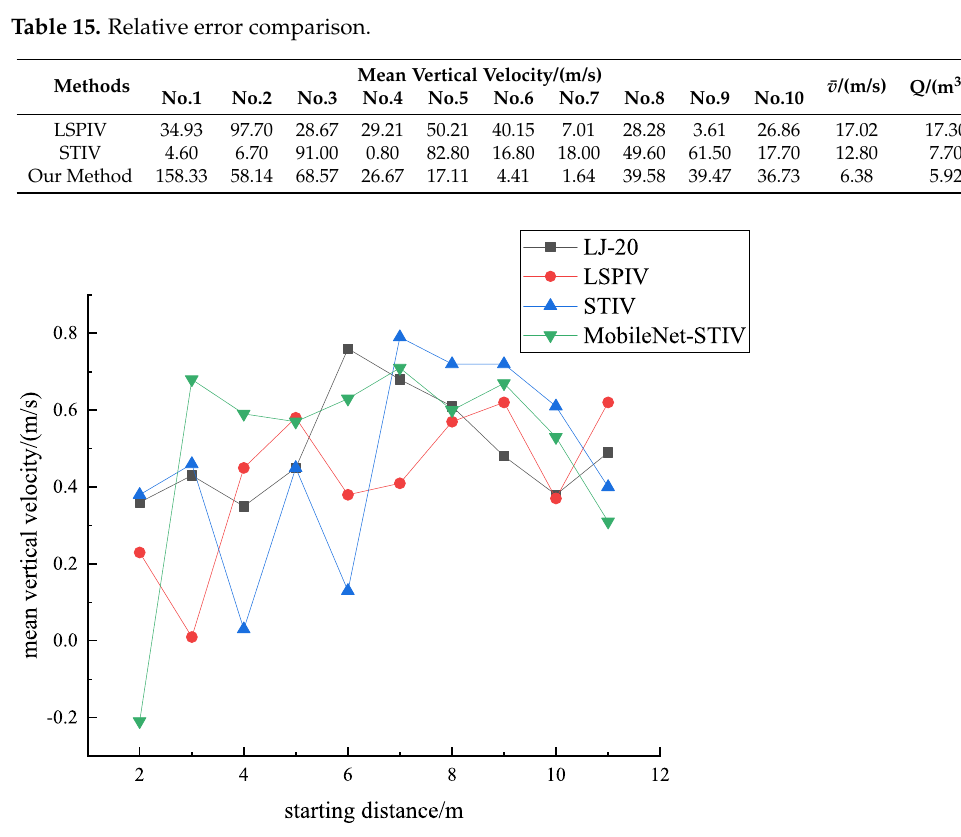
Figure 20. Comparison of mean vertical flow